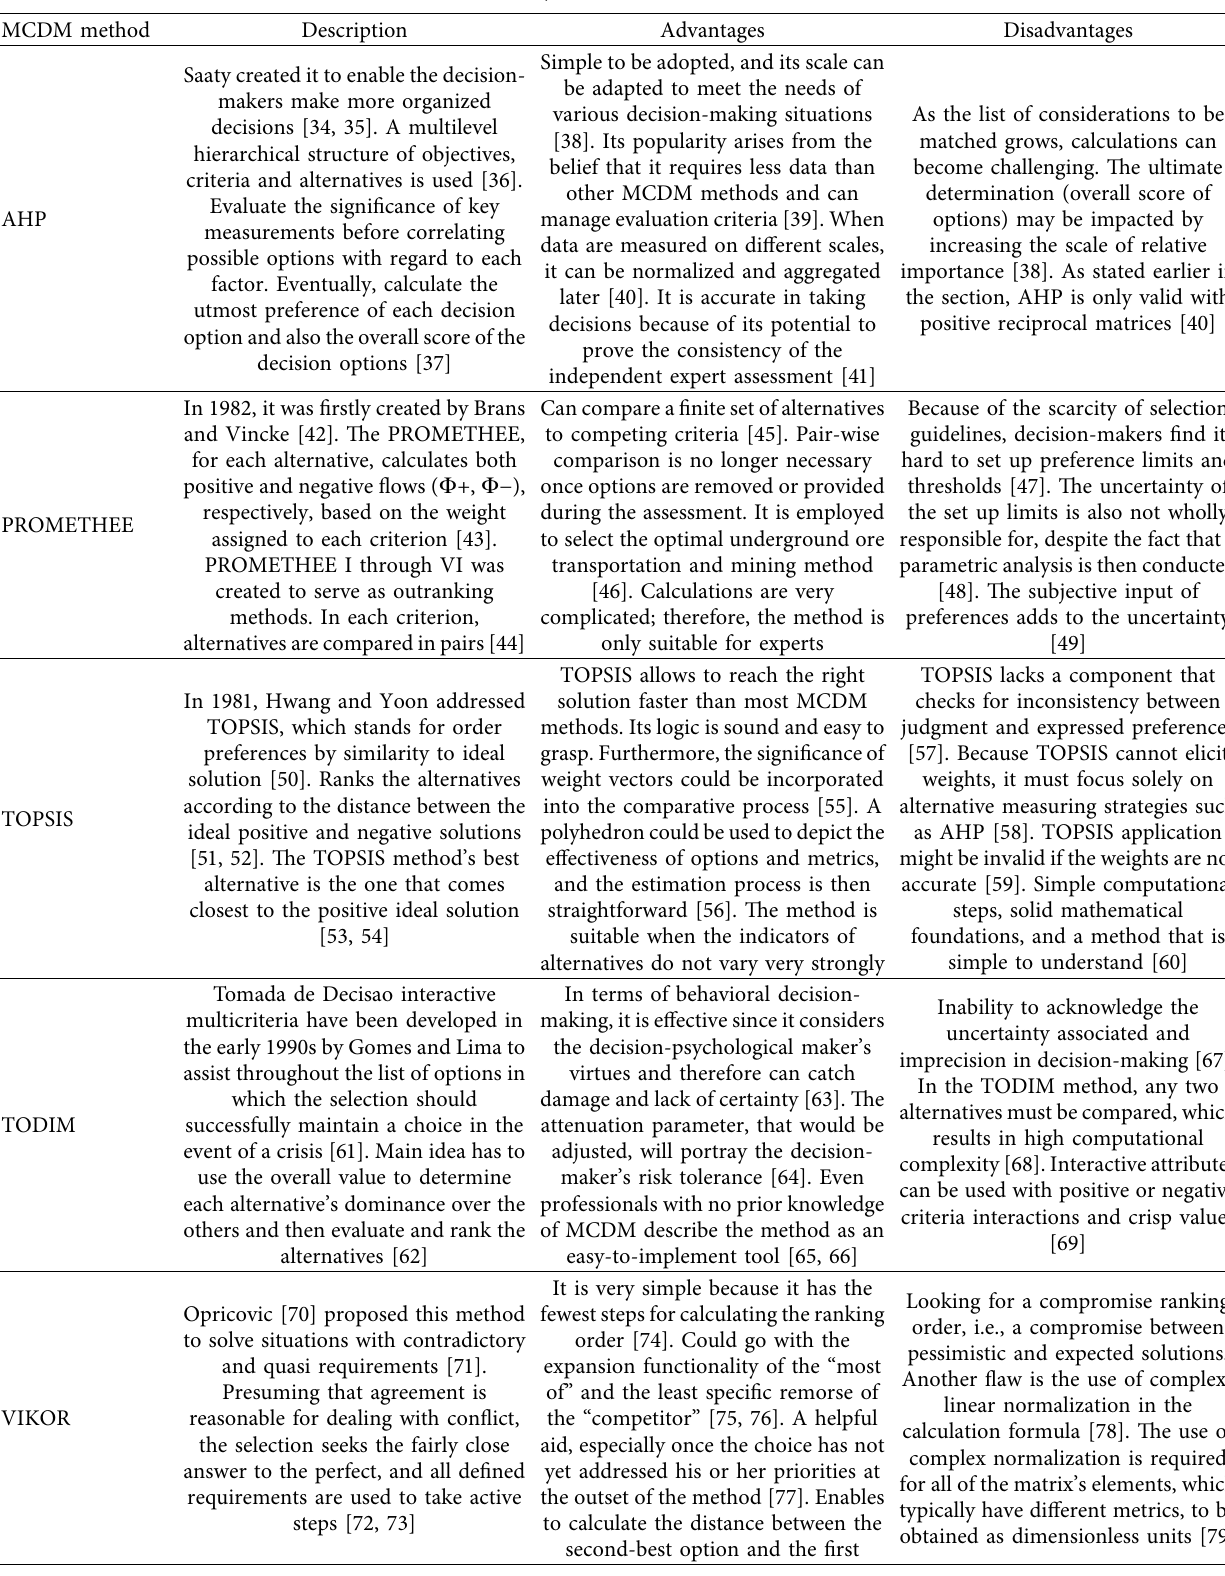
Table 2: Summary of the various MCDM